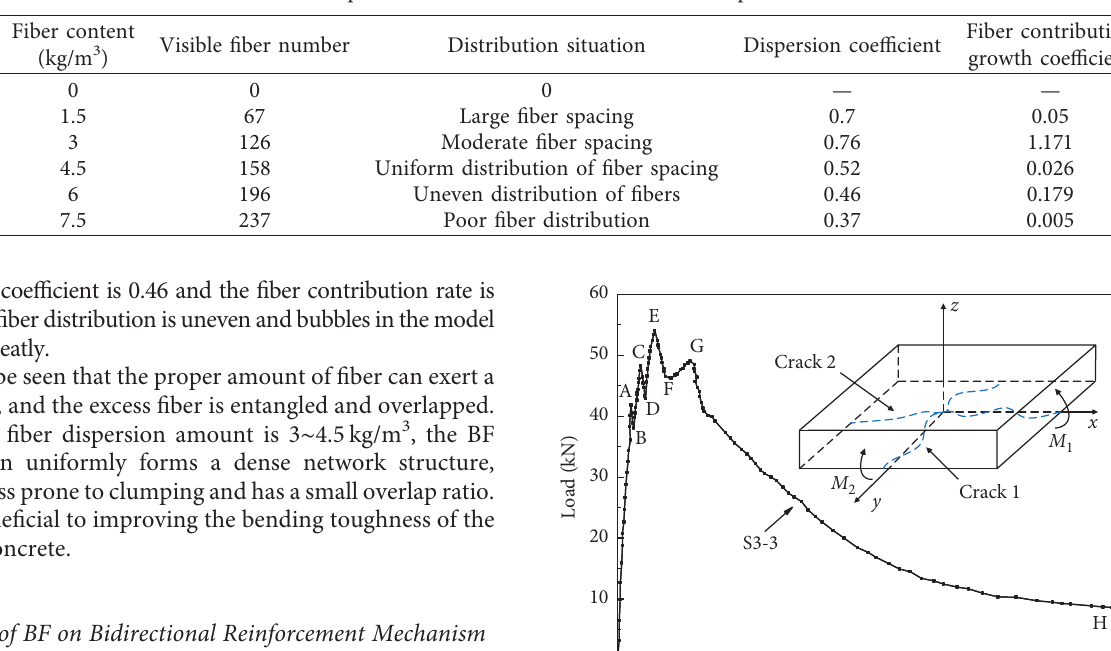
Figure 3: Binarization model of fiber-transparent soil with different content. (a) 0kg/m 3 .(b) 1.5kg/m 3 .(c) 3kg/m 3 . (d) 4.5kg/m 3 .(e) 6kg/m 3 . (f) 7.5kg/m 3 Table 3: The dispersion of different content of BF in transparent soil.